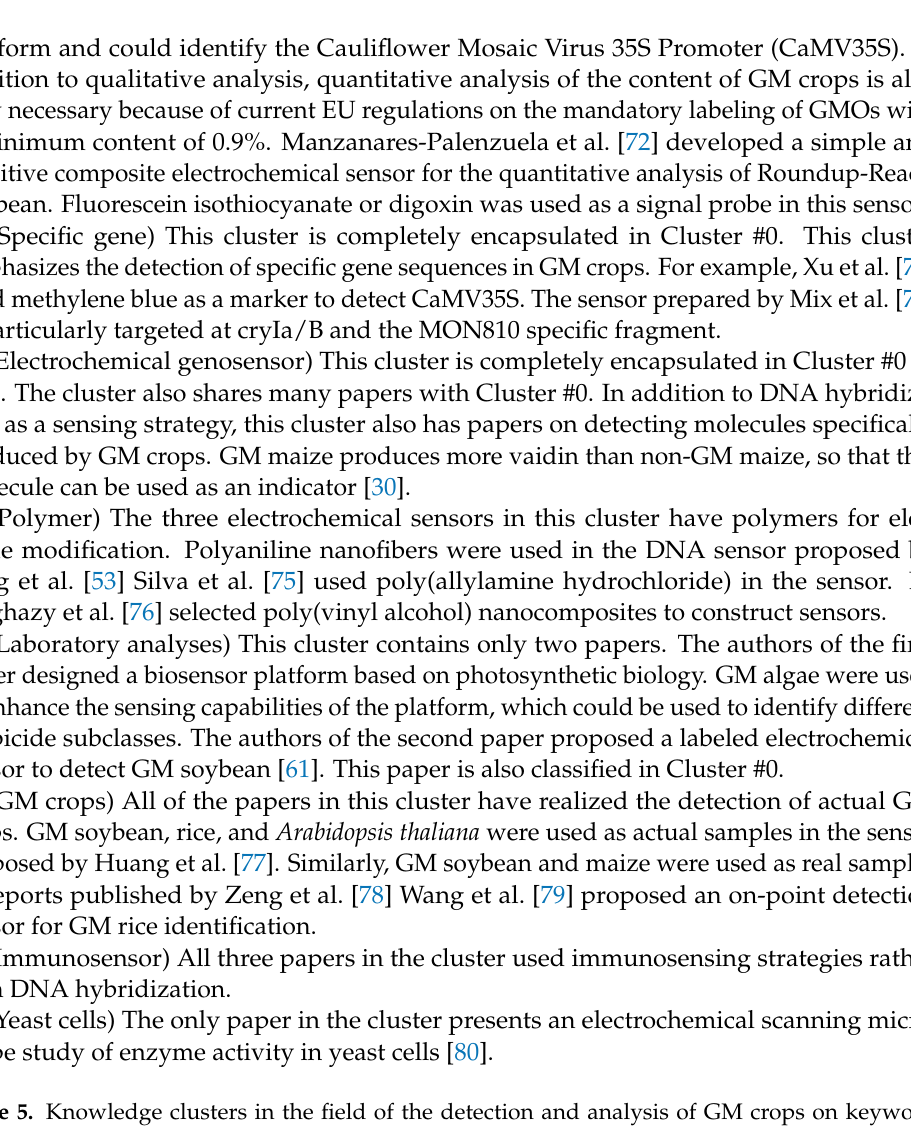
Table 5. Knowledge clusters in the field of the detection and analysis of GM crops on keyword co-occurrences for each